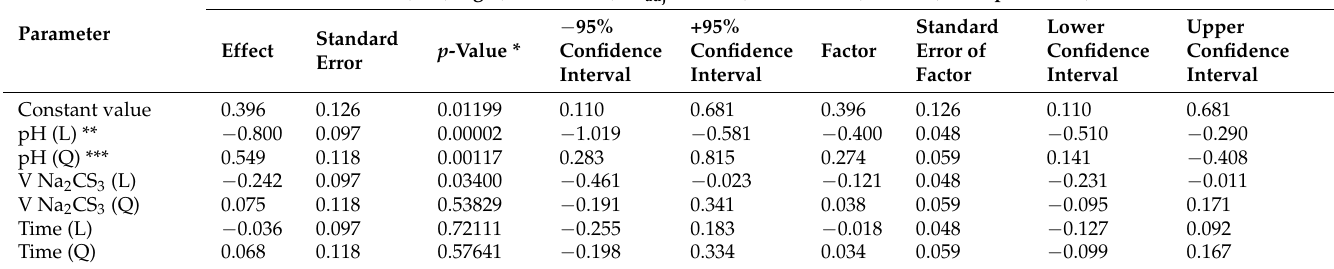
Table 5. Analysis of the experiments’ findings after eliminating statistically insignificant linear interactions ((L) relative to (L)) of the parameters—final assessment of the effects by Statistica 13.